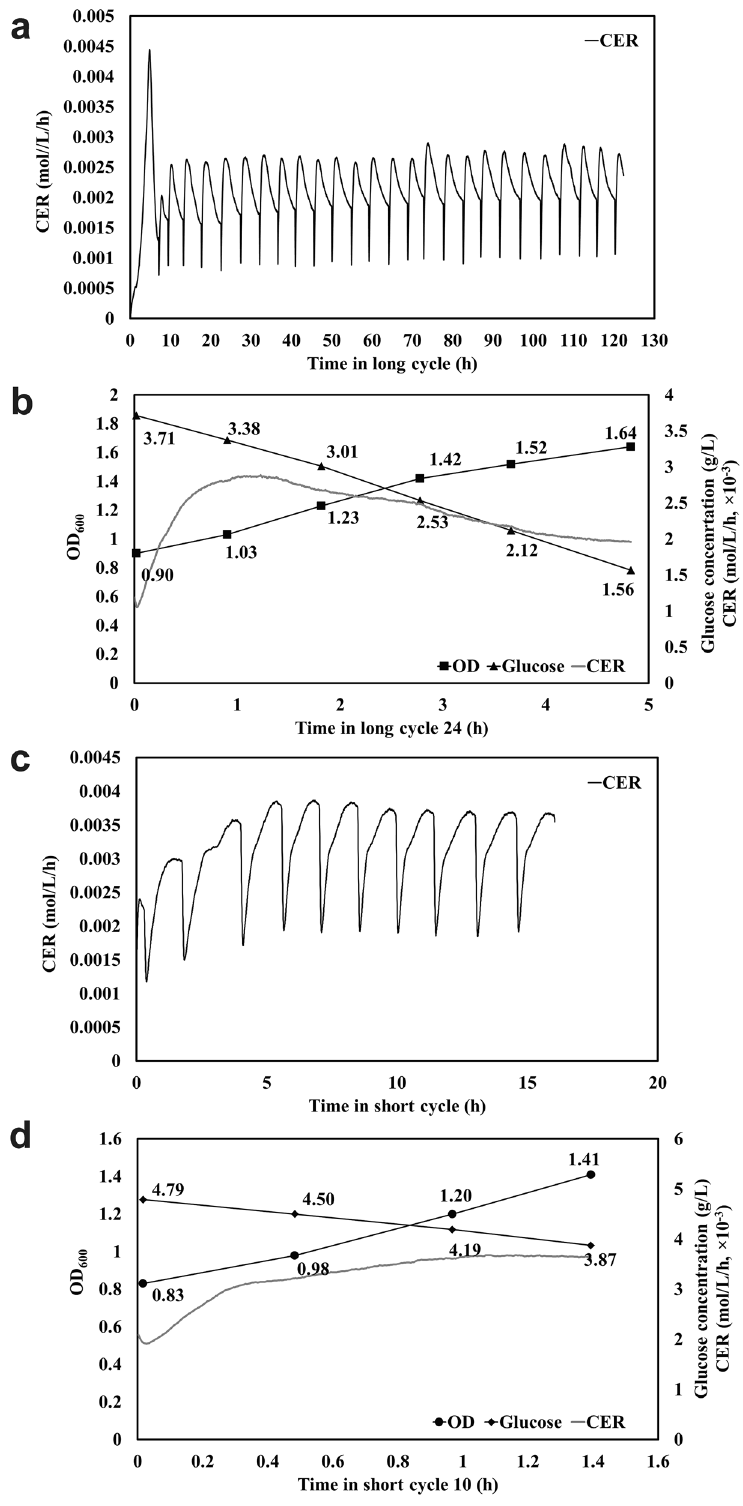
Figure 3. E. coli grown in SCF long-cycle and short-cycle schemes. Long-cycle scheme: ( a ) CER, and ( b ) intracycle OD 600 , glucose concentration and CER in long cycle 24. Short-cycle scheme: ( c ) CER, and ( d ) intracycle OD 600, glucose concentration and CER in short cycle